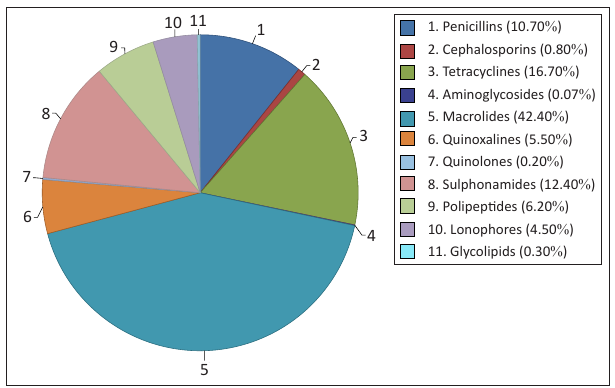
FIGURE 1: Percentages of volume (kg) for sales of classes of antimicrobials for the period